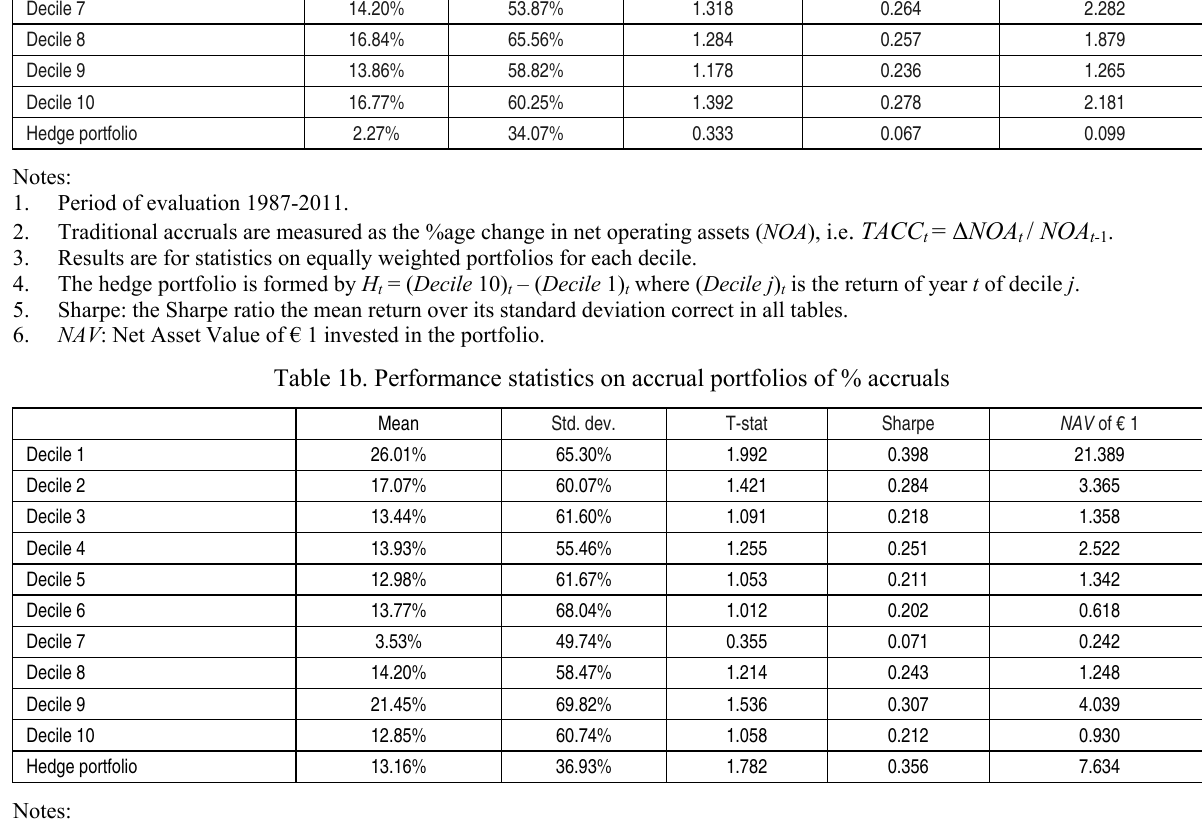
Hedge portfolio